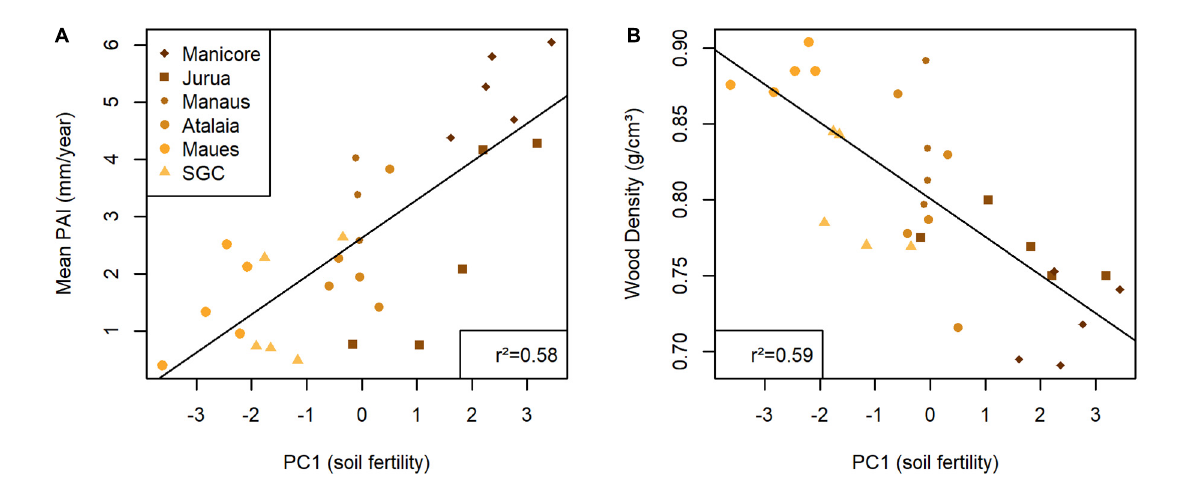
FIGURE4 Graphics showing the distribution points between Eschweilera coriacea traits varying by axis 1 (PC1) from the principal component analysis calculated using soil data expressing the soil fertility, were: (A) PAI (mm/year)–Periodic annual increment. (B) Wood density (g/cm 3 ). The black line indicates the tendency line of the regression from each data set. Acronyms of the study sites: Manicore, Manicoré; Jurua, Juruá; Manaus, Manaus; Atalaia, Atalaia do Norte; Maues, Maués; SGC, São Gabriel da Cachoeira.